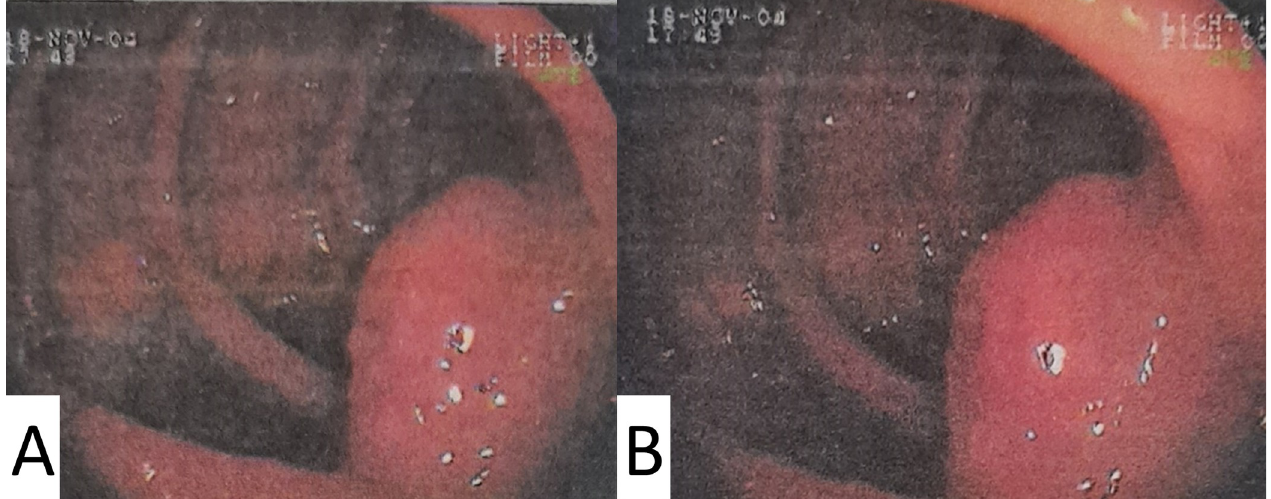
Fig 2. Colonoscopy: Vegetating lesion in the cecum with an irregular and friable surface.